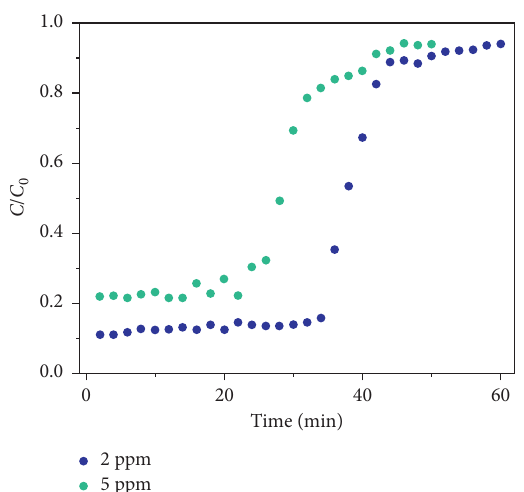
Figure 14: Removal of phosphorus by fixed-bed column (HRT � 10min and dosage � 20 g). Table 8: Trace metal element concentrations in the effluent (compared with leaching concentrations from raw materials). Water samples after Metals (mg L − 1 )